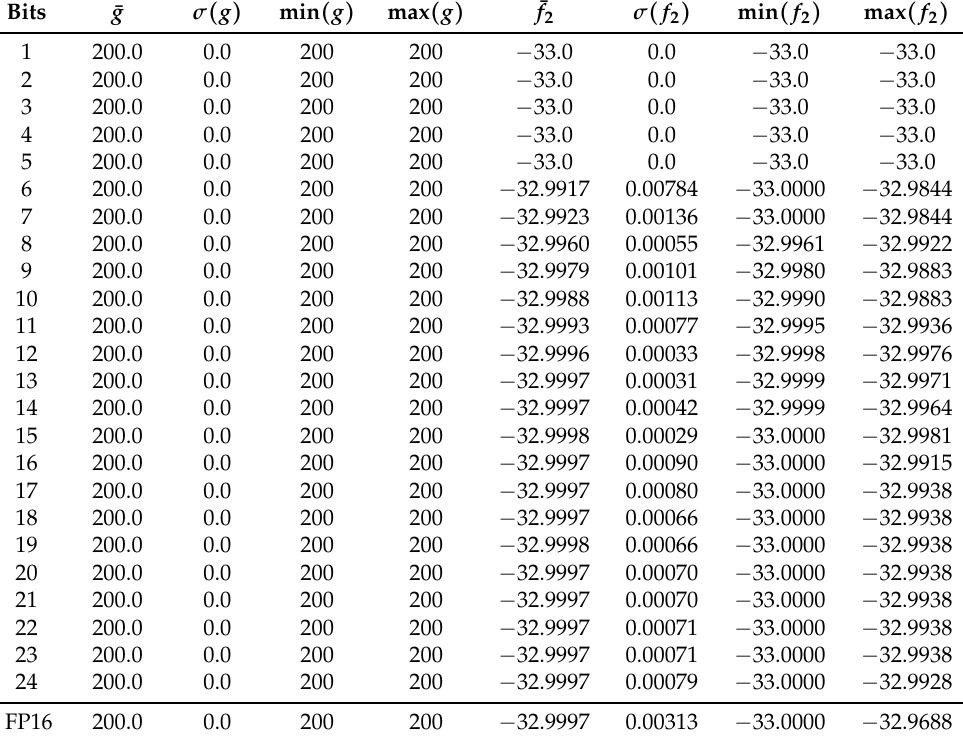
Table 5. Simulation results for Rastrigin function. Statistics of the 100 runs per bits used in the fractional part for the fixed point arithmetic (7 bits were used for the integer part). Results for 100 runs for the FP16 are also shown. g is the number of